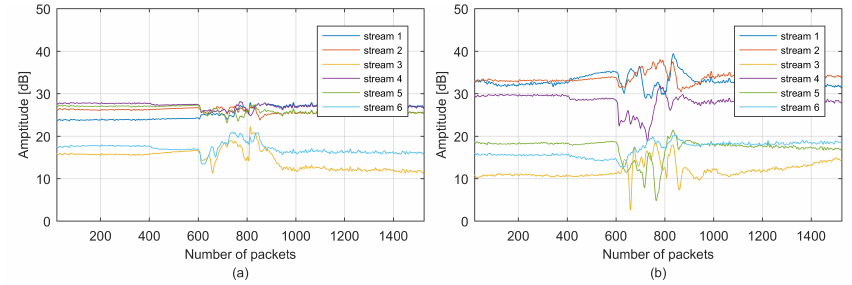
Figure 5. CSI subcarrier fusion: ( a ) averaging subcarrier fusion; ( b ) PCA subcarrier